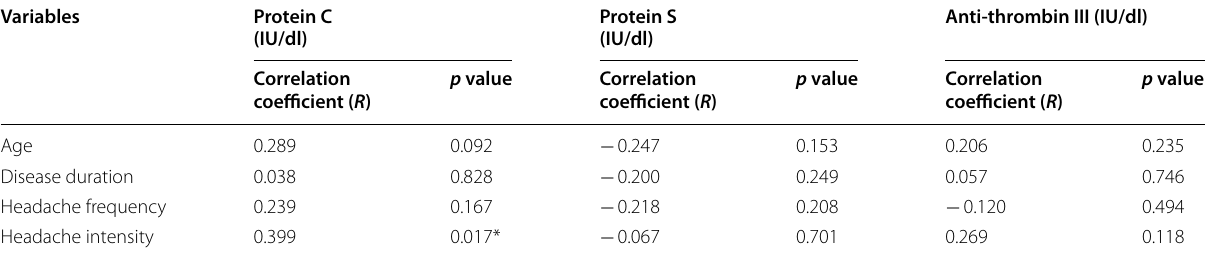
Table 5 Correlation between age, disease duration, headache frequency and headache intensity with serum level of protein C, protein S and anti-thrombin III